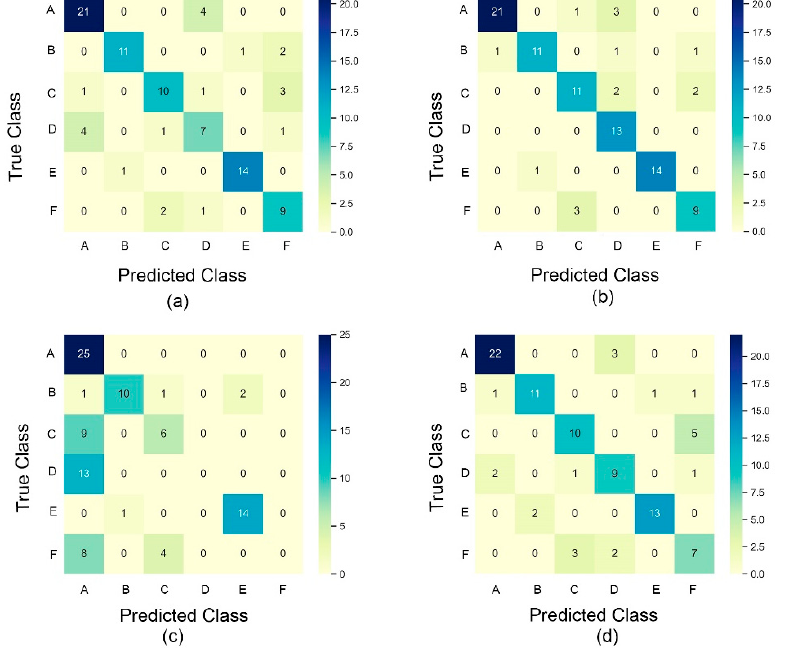
Figure 7. Classification results for different tree species using tree attributes. A, B, C, D, E, and F represent Fraxinus pennsylvanica , Ginkgo biloba , Robinia pseudoacacia , Acer negundo , Populus tomentosa , and Koelreuteria paniculate, respectively. ( a ) Random forest; ( b ) back propagation (BP) neural network; ( c ) support vector machine; and ( d ) K-nearest neighbor. Table 5. Classification results of different algorithms. RF, random forest; BP, back propagation; SVM, support vector machine; KNN, K-nearest neighbor.